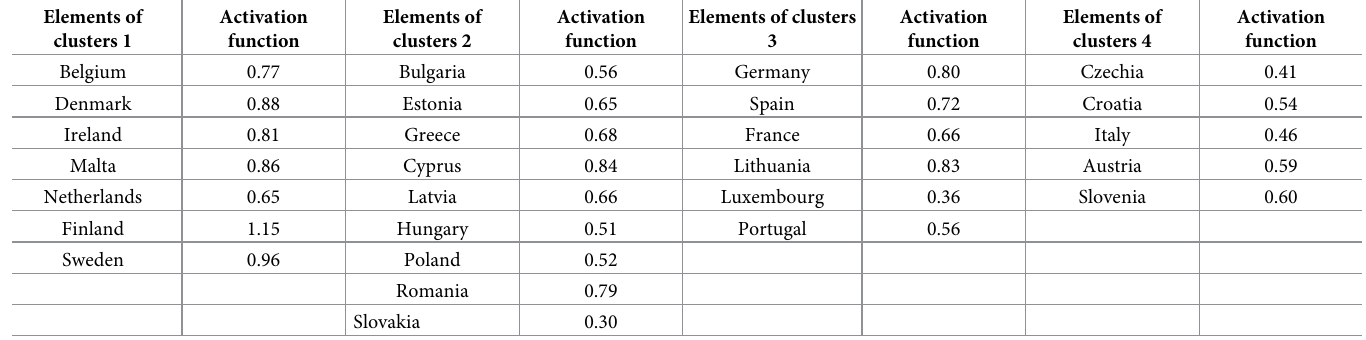
Table 8. The division of the EU countries into similar groups based on the examined indicators for small enterprises together with activation values (distance from the center of the cluster). Elements of clusters